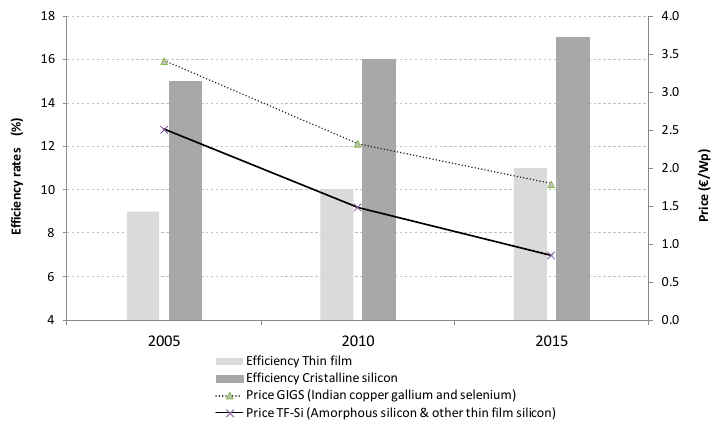
Figure 4. Price and efficiency rates development for different PV technologies [61].